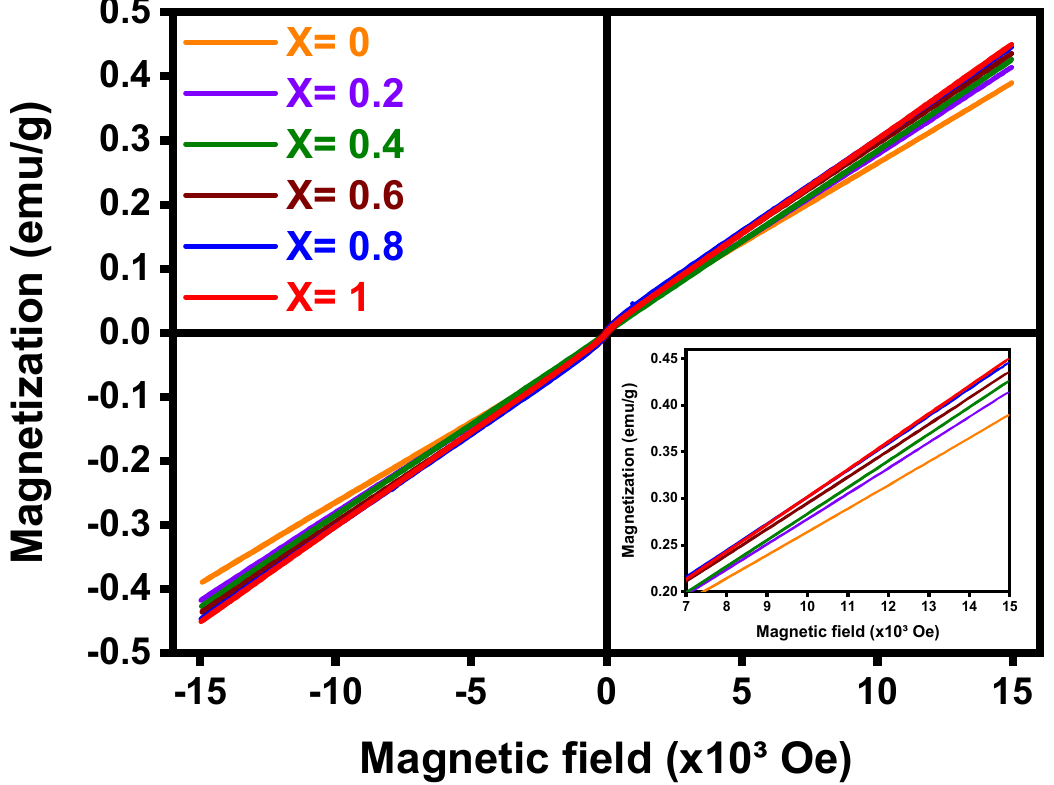
Figure 10. Magnetization curve of Mn X Co 3-X O 4 (0 ≤ X ≤ 1).